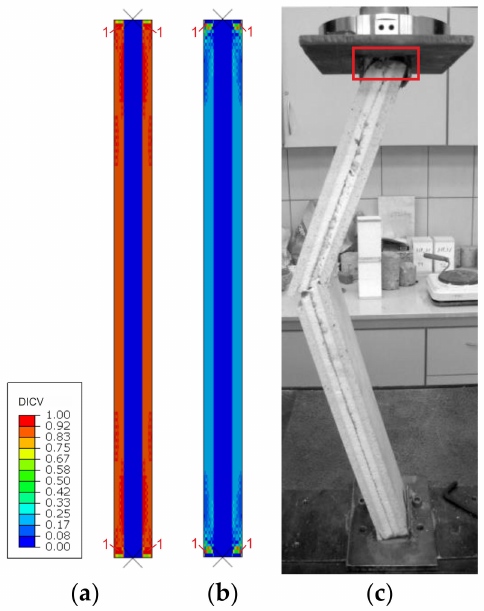
Figure 9. Comparison of failure modes in the L2 sample compression test obtained from FEA ( a ) MgO min, ( b ) MgO max variants, and ( c ) experimental